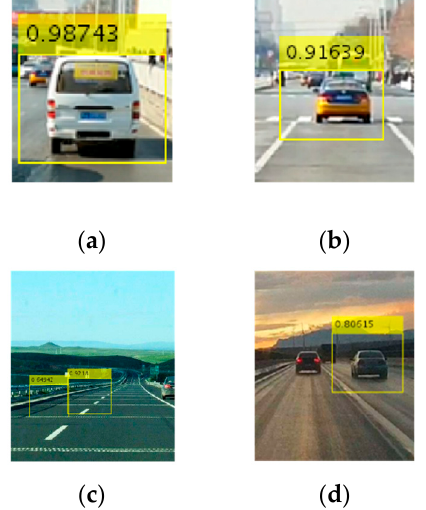
Figure 4. Vehicle detection results. ( a ) Correct vehicle test results; ( b ) Correct vehicle test results; ( c ) Correct vehicle test results; ( d ) Correct vehicle test results.